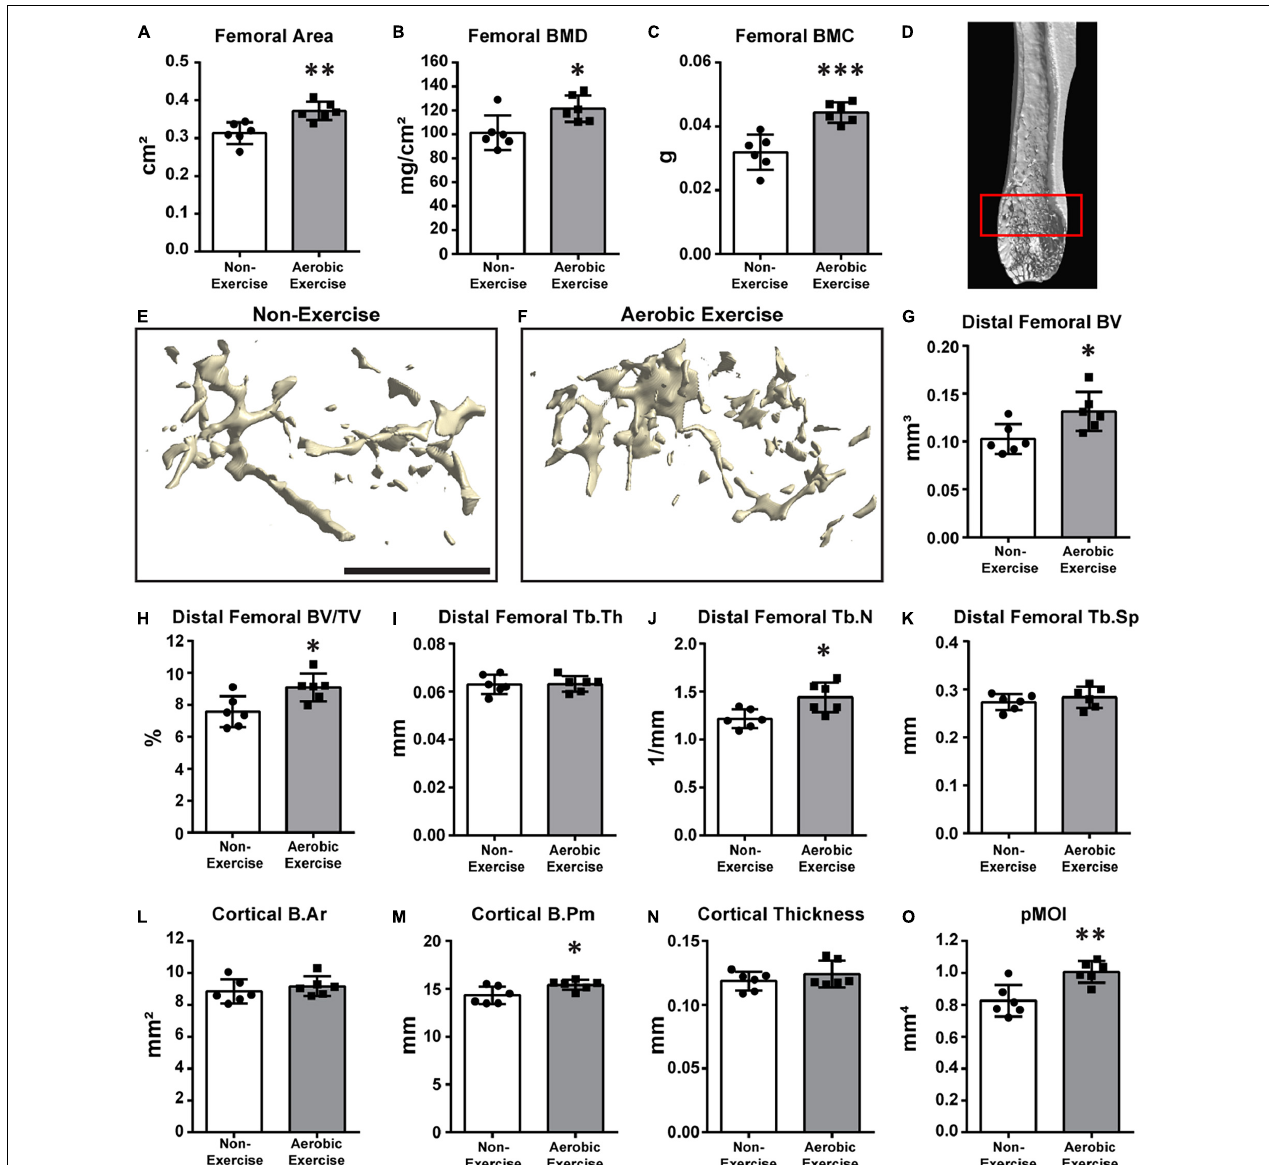
FIGURE 1 | Higher distal femoral BMD, BMC, trabecular bone microarchitecture, and cortical bone perimeter following aerobic exercise training. Quantification of area, BMD, BMC of distal femora (A–C) . Femoral area was higher ( p < 0.01) in Aerobic Exercise group vs. Non-Exercise group (A). Femoral BMD ( p < 0.05) and BMC ( p < 0.001) were significantly greater in mice with aerobic exercise compared to mice without exercise training (B,C) . Representative 3D µ CT reconstruction images of region of interest [ (D) red box] and distal femoral trabecular bone microarchitecture in Non-Exercise and Aerobic Exercise groups (E,F). Distal femoral BV was higher ( p < 0.05) in Aerobic Exercise group vs. Non-Exercise group (G) . Femoral BV/TV was significantly greater in mice with aerobic exercise compared to Non-Exercise group ( p < 0.05) (H). Femoral Tb.N was significantly higher ( p < 0.05) in Aerobic Exercise group compared to Non-Exercise group (J) . Cortical B.Pm (M) and pMOI (O) of distal femur were significantly higher with aerobic exercise, while trabecular Tb.Th (I) , Tb.Sp (K) , Cortical B.Ar (L) , and Cortical thickness (N) did not differ between groups. Black scale bar: 1 mm. N = 6 per group. Values are means ± S.D. ∗ p < 0.05, ∗∗ p < 0.01, and ∗∗∗ p <